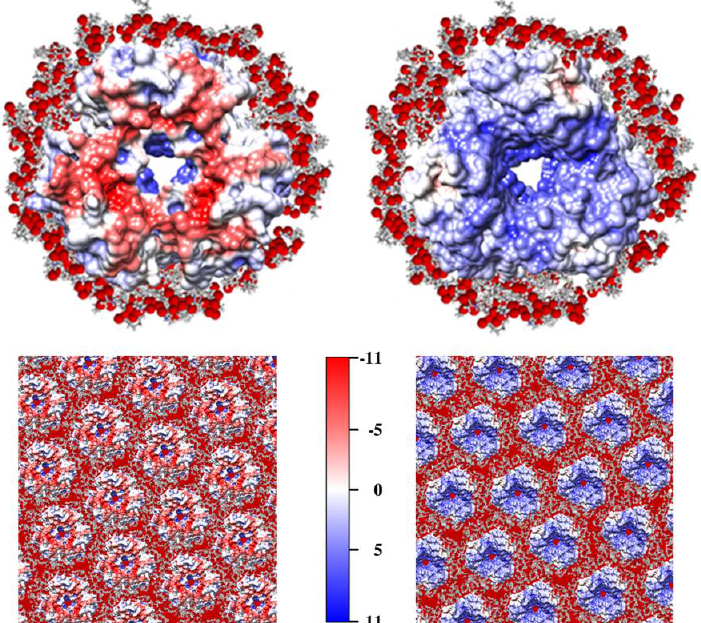
Figure 2. Molecular models of bacteriorhodopsin trimer (3bR) with adjoining 30 lipid molecules (the upper two pictures) and a part of the purple membrane (the lower two pictures). The left two pictures show the intracellular (cytoplasmic) surface of bR and PM and the right two pictures show the extracellular surface. The colors correspond to the sign and value of the electrostatic potential at pH 6.0: Negative (red) and positive (blue) in the range of − 11 kT / e to +11 kT / e . The red points around the bR trimer represent the oxygen atoms in the heads of the lipid molecules.